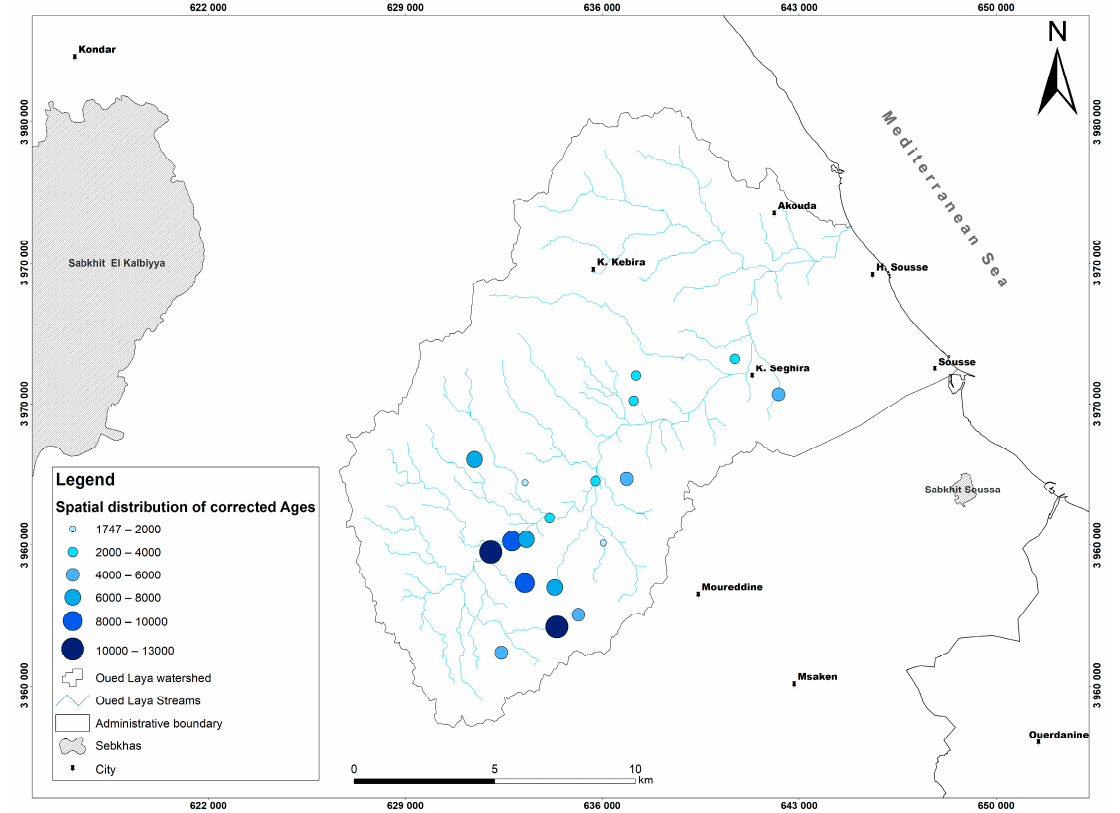
Figure 14. Spatial distribution of Carbon 14 corrected ages.